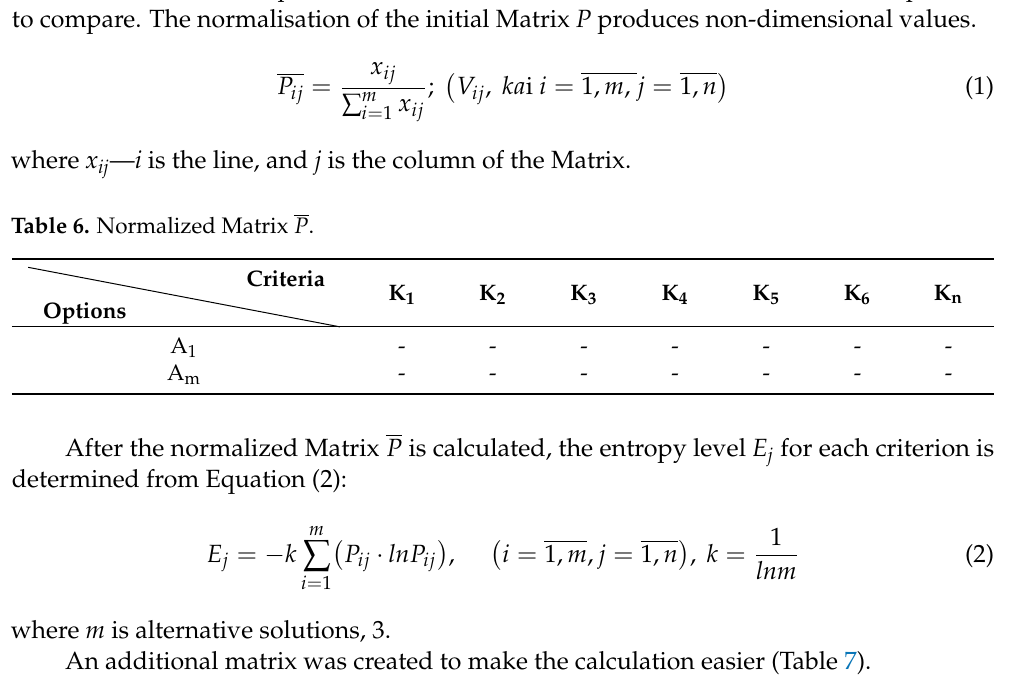
(cid:16) (cid:17) P ij · lnP ij